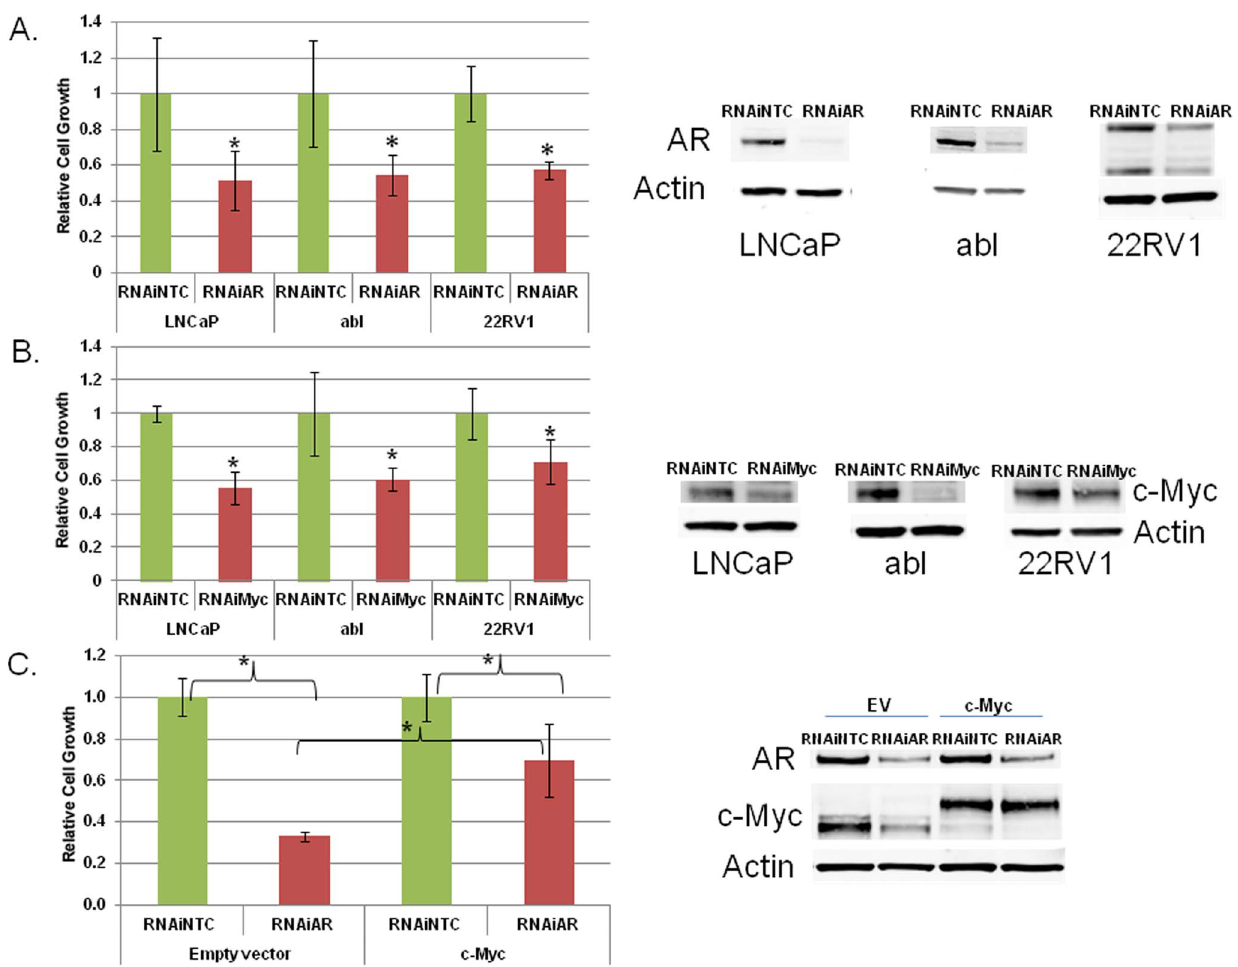
Figure 2. AR and c-Myc promote ligand-independent prostate cancer cell growth. A) LNCaP, abl and 22RV1 cells were transfected with 50 nM of non-targeted control (NTC) or AR RNAi oligonucleotides. Cells were switched to charcoal-stripped serum on the day of transfection. Cell growth was determined 5 days later for LNCaP and 6 days later for abl and CRPC 22RV1 with the trypan blue exclusion method. B) Immunoblot for AR expression. The lower bands in the AR immunoblot in 22RV1 cells reflect the presence of an AR transcript variant [7]. B) LNCaP, abl and 22RV1 cells were transfected with 50 nM of NTC or c-Myc RNAi oligonucleotides. Cells were switched to charcoal-stripped serum on the day of transfection. Cell growth was determined 5 days later for LNCaP cells and 6 days later for abl and 22RV1 with the trypan blue exclusion method. Immunoblot for c-Myc protein expression. C) LNCaP cells with stable overexpression of empty vector (EV) or c-Myc were generated. These cells were transfected with 50 nM of non-targeted control (NTC) or AR siRNA oligonucleotides. Cell growth was determined 6 days later with the trypan blue exclusion method. Immunoblot for AR and c-Myc protein expression. The higher bands on the c-Myc immunoblot in the c-Myc-overexpressing cells represent the ectopically-expressed c-Myc. *denotes p , 0.05 compared to